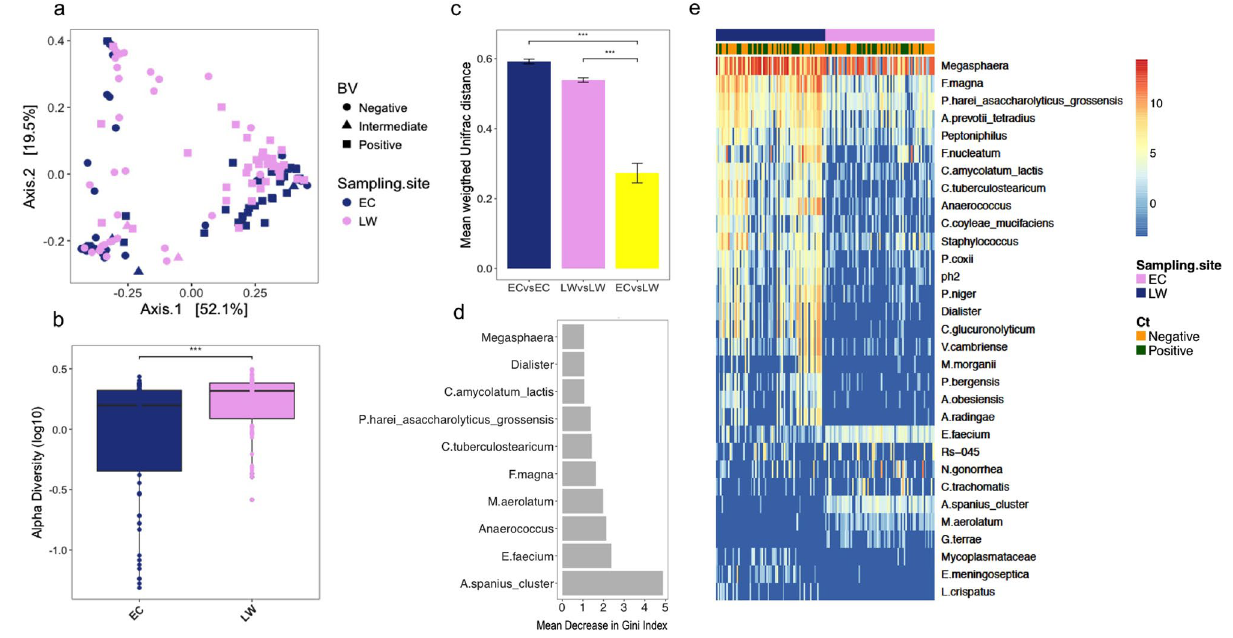
Figure 2. Taxa significantly different between vaginal lateral wall versus endocervical microbiota. ( a ) Principal Coordinates Analysis (PCoA) of the vaginal and endocervical microbiota using weighted UniFrac distances. Individual samples are colored by anatomical sampling site (endocervical:EC and lateral vaginal wall:LW) with BV status displayed as shapes. ( b ) Boxplot depicting the alpha diversity of the vaginal lateral wall (LW) and endocervical (EC) microbiota. ( c ) Taxa significantly differentially abundant and/or frequent by anatomical site category by metagenomeSeq (FDR ≤ 0.05, coefficient ≥ 1.25, taxa present in ≥ 20% of samples in at least